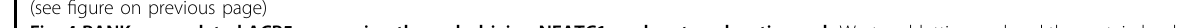
Fig. 4 RANK upregulated ACP5 expression through driving NFATC1 nuclear translocation. a , b Western blotting analyzed the protein levels of phosphorylated NFATC1 and NFATC1 in cytoplasm, and nucleus of RANK -overexpressing or knockdown CRC cells. GAPDH served as the cytoplasmic control and lamin B1 as the nuclear protein loading control. c Immuno fl uorescence staining of subcellular localization of NFATC1 in RANK overexpression and control cells with or without treatment of 10 μ g/ml cyclosporin A (CsA). Scales bars = 20 μ m. d Representative immuno fl uorescence of subcellular localization of NFATC1 in RANK -depleted HT29 cells. Scales bars = 20 μ m. e The NFATC1 subcellular localization in matched normal tissues, negative and high RANK expression of CRC tissues by immuno fl uorescence staining. DAPI (nuclei, blue). RANK is visualized in the membranes and in the cytoplasm surrounding the nucleus of the NFATC1 in CRC tissues (white arrowheads). − (score 0), +++ (score 9 – 12). N paired normal colorectal tissues. Scales bars = 10 μ m. f – h Correlation analysis between mRNA levels of NFATC1 and ACP5 from indicated online datasets. i ChIP-seq data showed a UCSC Genome Browser screenshot of the ACP5 promoter region for NFATC1 and SPI1 in GM12878 cells and MITF, SPI1, and JUN in K562 cells from ENCODE. j NFATC1 knockdown reversed RANK-induced ACP5 expression. k , l Silencing of NFATC1 decreased RANK-induced migration and invasion in SW480 and Caco2 cells. Scales bars = 100 μ m. Data are mean± SD ( n = 3). * P < 0.05, ** P < 0.01, *** P < 0.001, **** P